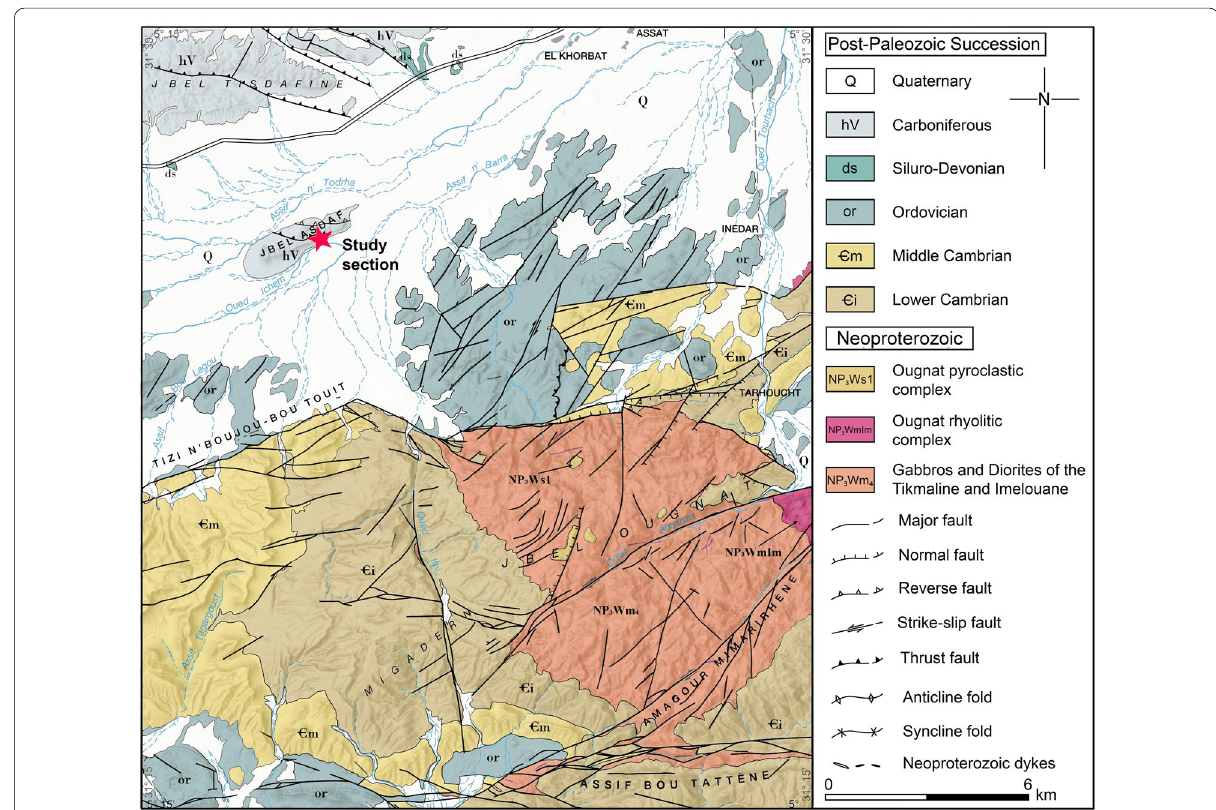
Fig. 2 Geological overview of the area (SW of Tinejdad), between the Carboniferous at Jebel Tisdafine and the Ordovician at Jebel Ougnate, showing the position of the lower Carboniferous of the Jbel Asdaf area (re-drawn from El Boukhari et al., 2007; Fig.